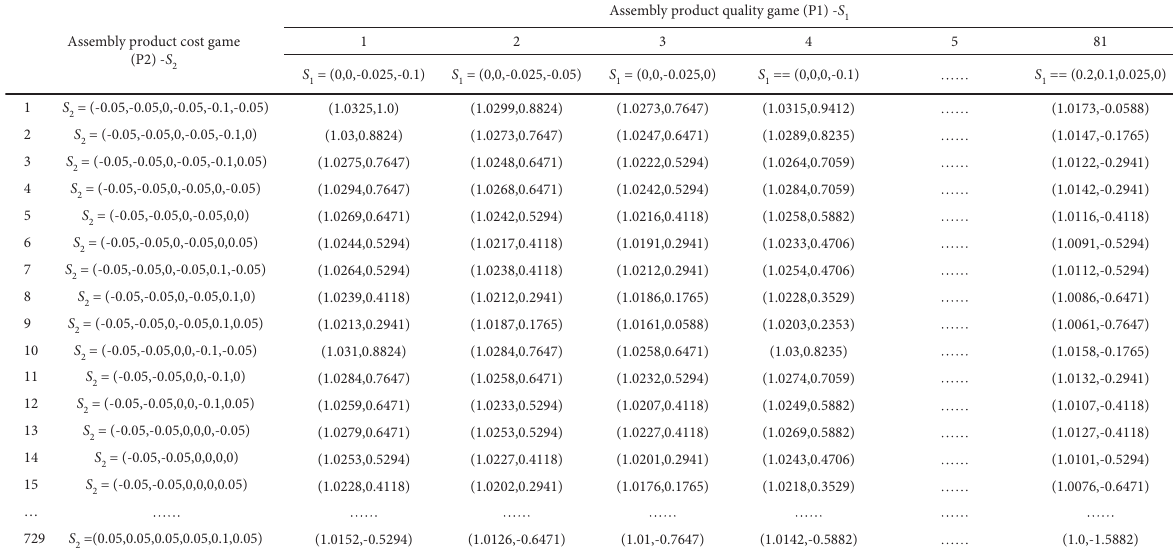
Figure 6: The game model of tolerance allocation.